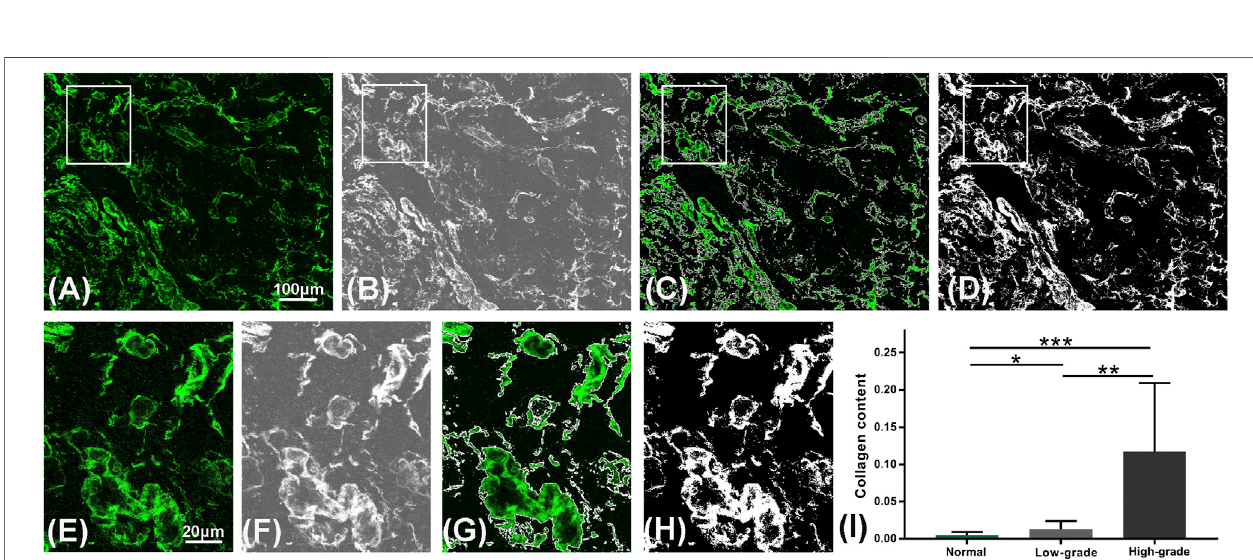
FIGURE7| Quantitativeanalysisofcollagen. (A – D) Representativesegmentationresultsoftheautomaticanalysisalgorithm:anoriginalSHGimageinahigh-grade glioma (A) ,theresultafterimageenhancement (B) ,thesegmentationresultofcollagenposition (C) andthe fi nalsegmentationresultofcollagencontent (D) aredisplayed from left to right. (E – H) Magni fi ed region marked in (A – D) . (I) Collagen content variations in the normal brain tissue, low-grade and high-grade gliomas using the